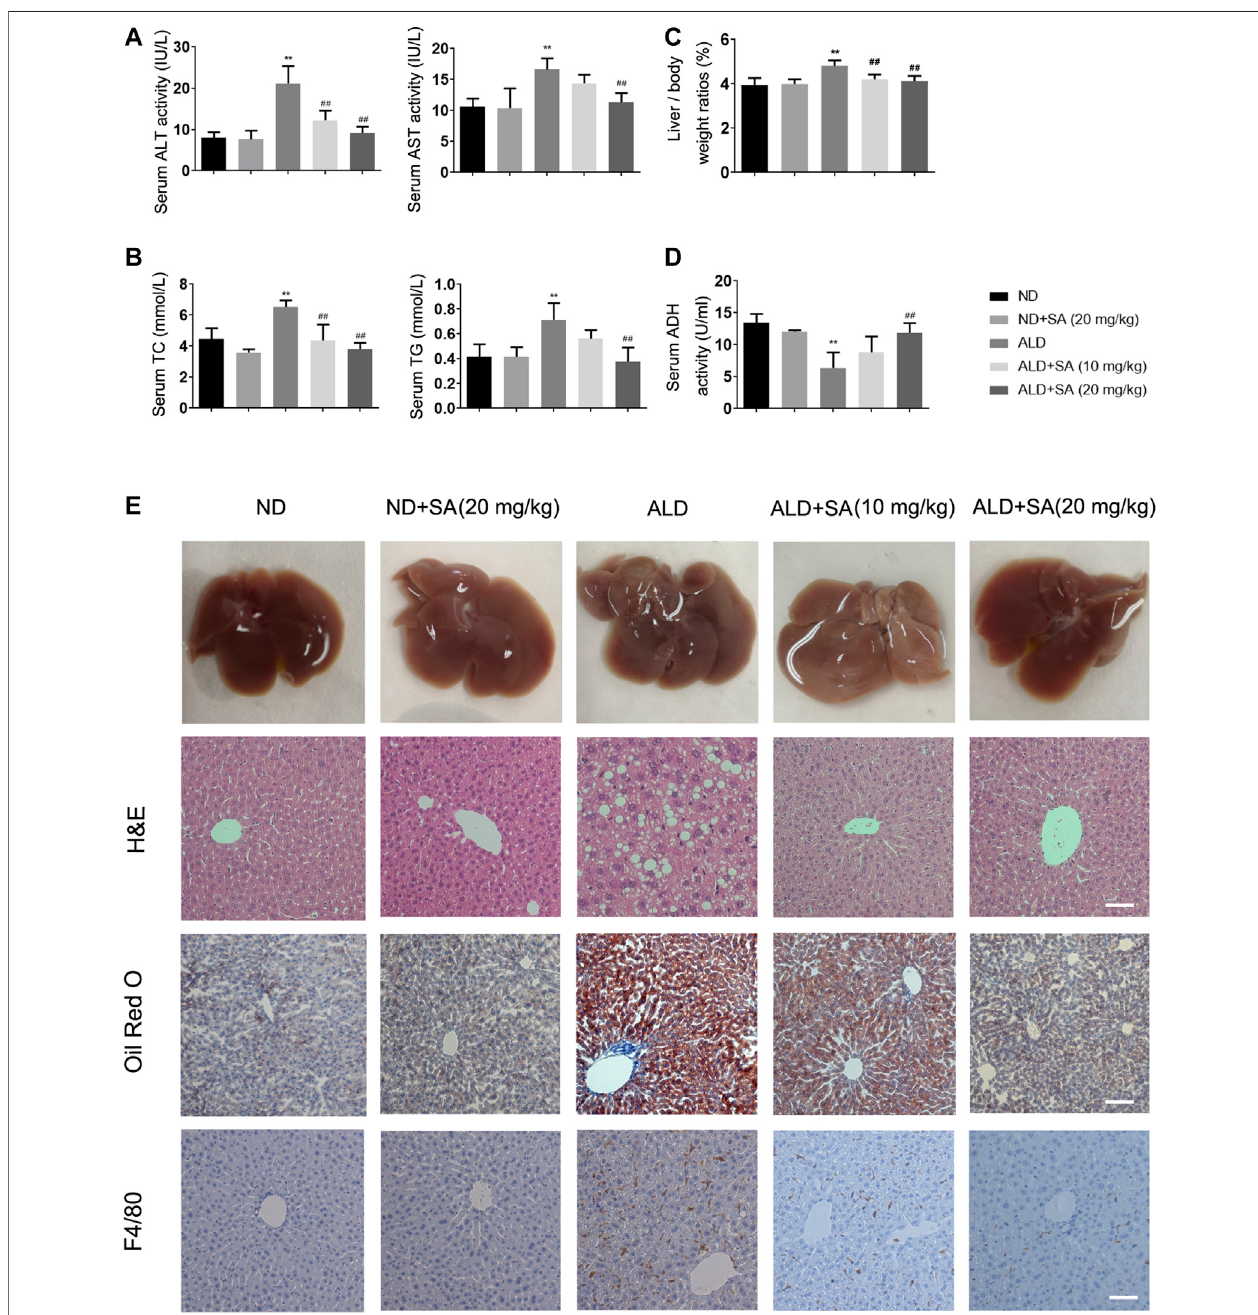
FIGURE1| SAdiminishesalcohol-inducedliverinjuryandsteatosisinmice. (A) SerumlevelsofALTandAST. (B) SerumlevelsofTCandTG. (C) Liver/bodyweight ratio (D) Serum ADH levels. The data are the mean ± SD ( n (cid:2) 8). (E) Representative morphological, H&E staining ( × 200), Oil Red O staining ( × 200) and F4/80 staining ( × 200) of liver sections from the different experimental groups: normal diet (ND), ND + SA (20 mg/kg), Lieber-DeCarli diet (ALD), ALD + SA (10 mg/kg), and ALD + SA (20 mg/kg). Scale bar (cid:2) 50 μ m ** p < 0.01 vs the ND group; ## p < 0.01 vs the ALD group.